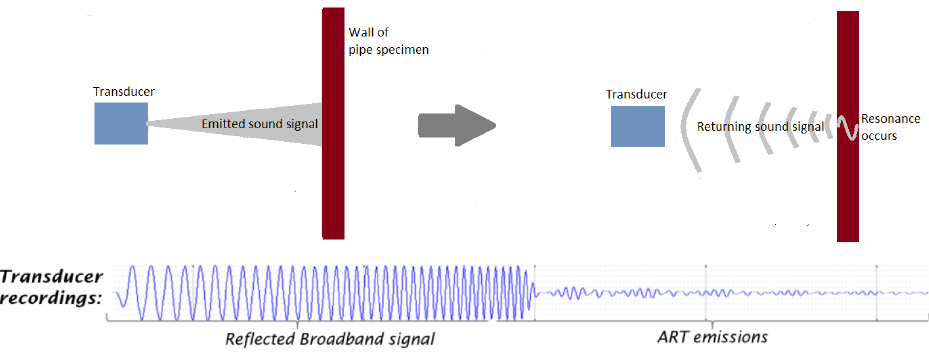
Figure 2. The operating principle of the acoustic resonance technology. Modified from